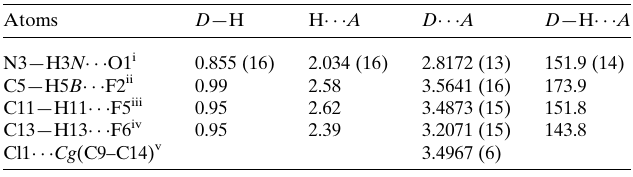
Table 1 Hydrogen bonds and other short contacts (A˚ , (cid:2) ) in I